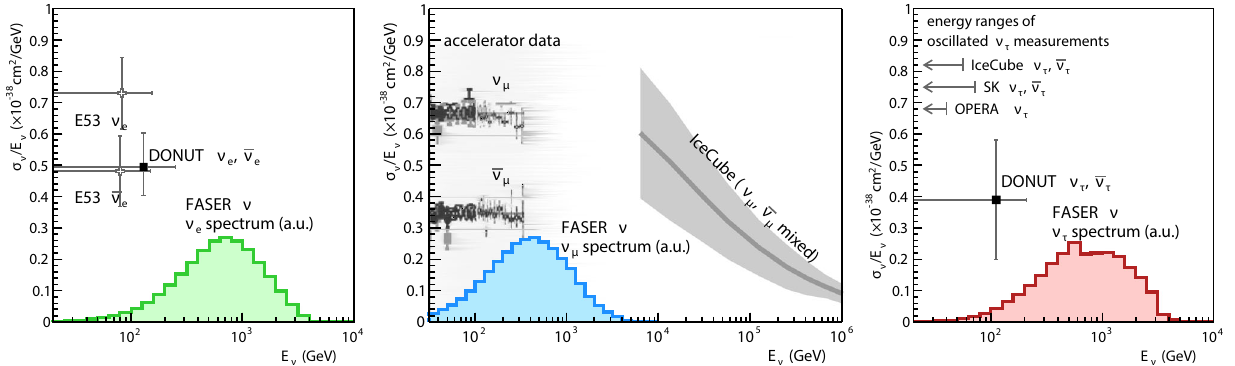
Fig. 3 Existing measurements of ν N CC scattering cross sections, where N refers to an isoscalar nucleon in the target, and the expected energyspectraofneutrinosthatinteractinFASER ν .Forallthreeflavors, theFASER ν energyspectra,shownascoloredhistograms,arepeakedat energies that are currently unconstrained. Left , ν e constraints : Bounds from E53 [39] and DONuT [40]. The bounds from E53 on σ ν σ ¯ ν /σ ¯ ν μ are multiplied by the current values of e tively. Center , ν μ constraints : Bounds from accelerator neutrinos at